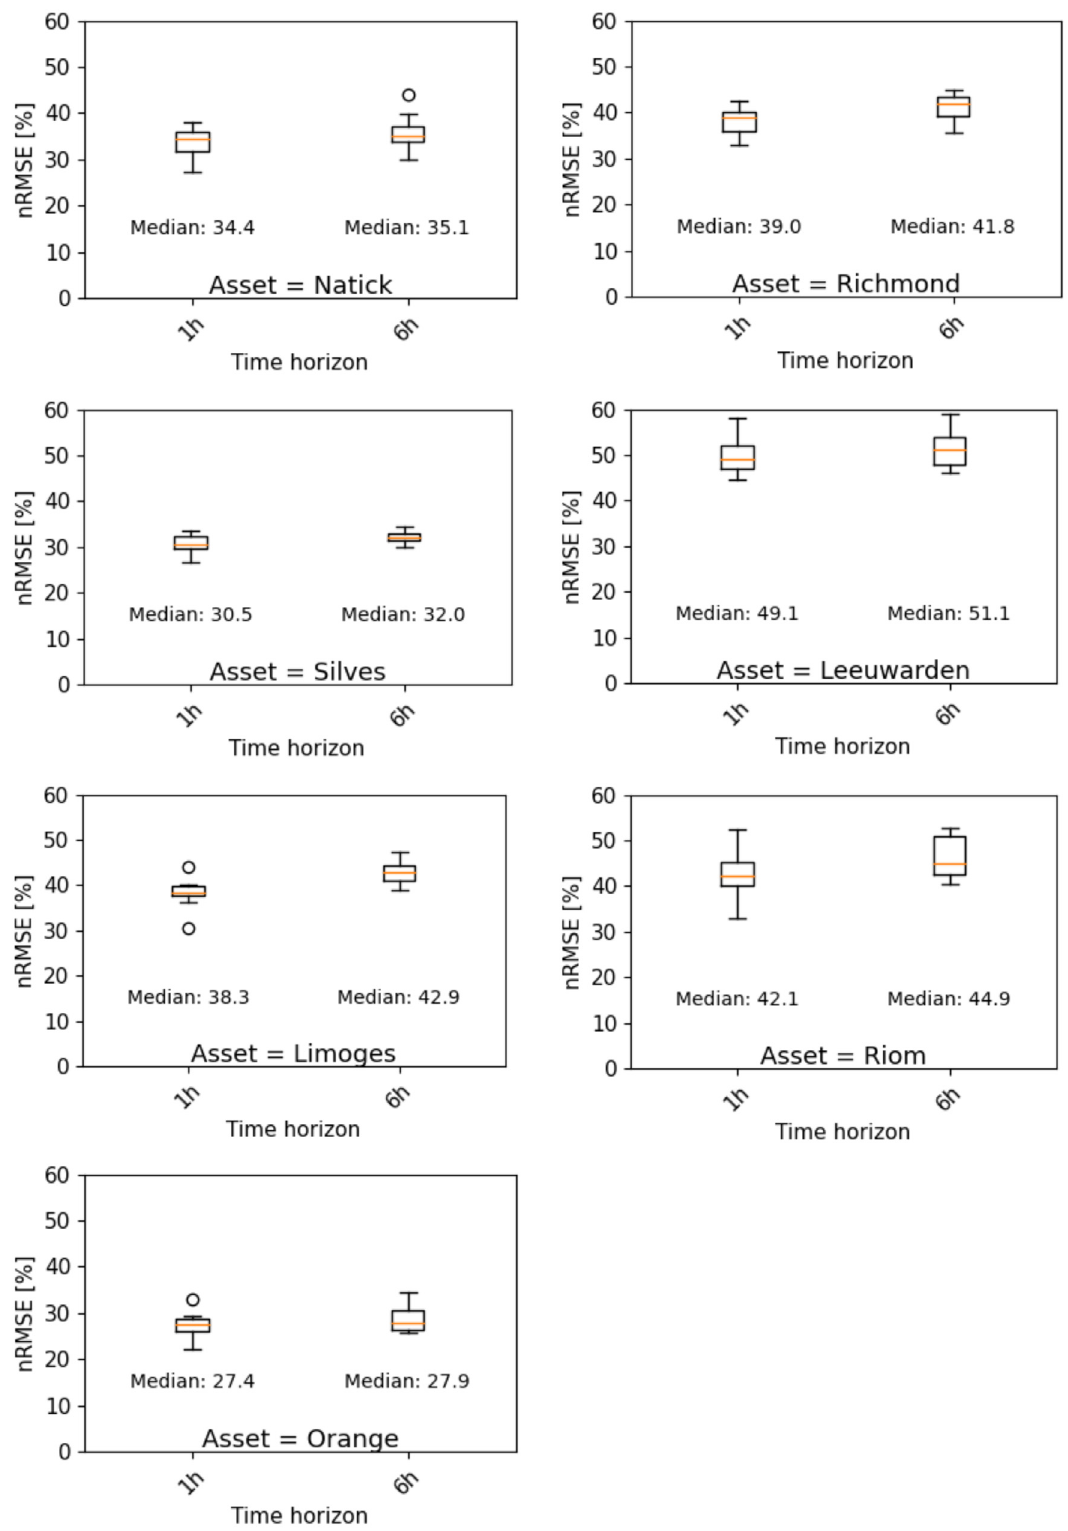
Fig. 3. Boxplot of nRMSE for all actors as a function of the PV plant for time horizon of 1 and